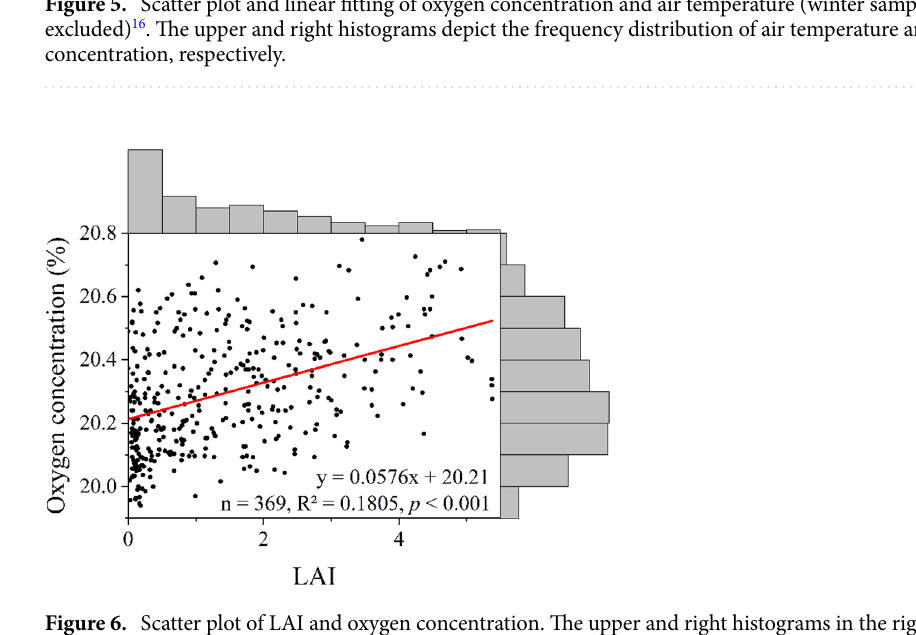
Figure 6. Scatter plot of LAI and oxygen concentration. The upper and right histograms in the right part represent the frequency distribution of LAI and oxygen concentration,